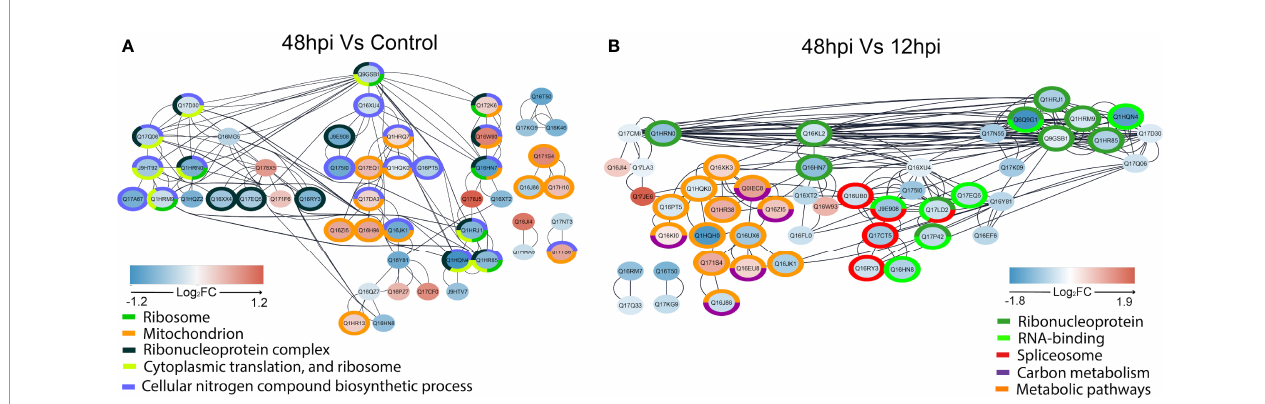
FIGURE 7 | STRING network interaction analysis of regulated proteins in 48 hpi vs. Control (A) and 48 vs. 12 hpi (B) . Interactions of regulated proteins analyzed by one-way ANOVA with post-hoc Bonferroni multiple test correction (p-value < 0.05) were assessed by STRING without text mining and imported to the Cytoscape, where overrepresentation analysis of biological terms was performed. The overrepresented terms are indicated by different colors in the legends, and the proteins that belong to these terms are circled in the respective colors. Log 2 FC are represented by fi lled colors (red for upregulated and blue for downregulated), and smaller node distances correspond to higher protein – protein interaction